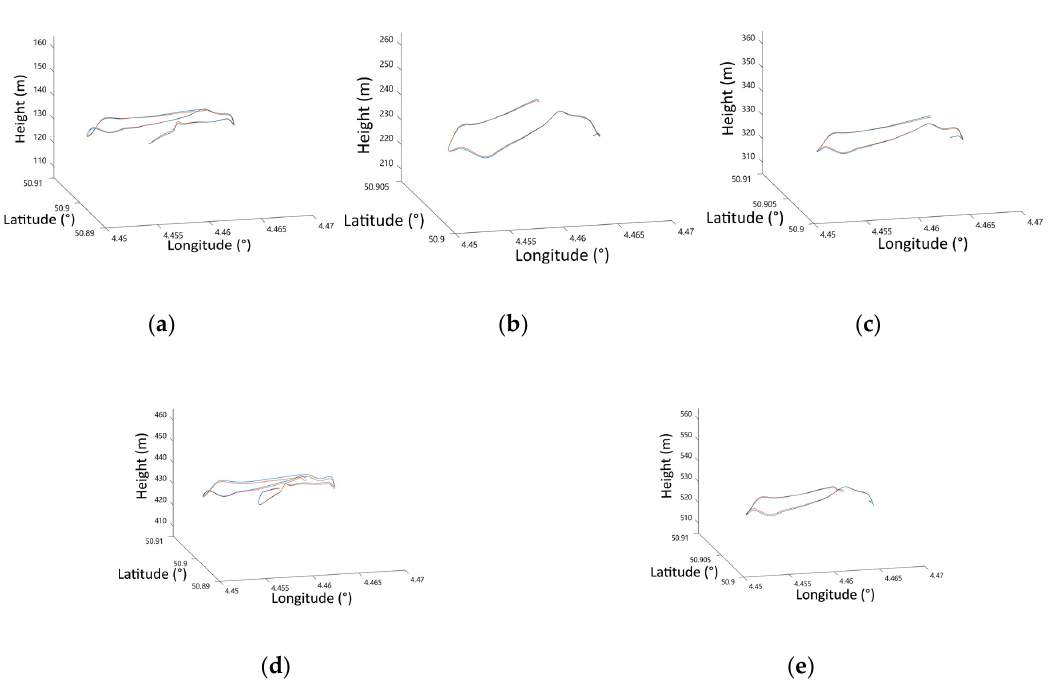
Figure 4. The trajectory estimation results. ( a ) 100 m height. ( b ) 200 m height. ( c ) 300 m height. ( d ) 400 m height. ( e ) 500 m height.